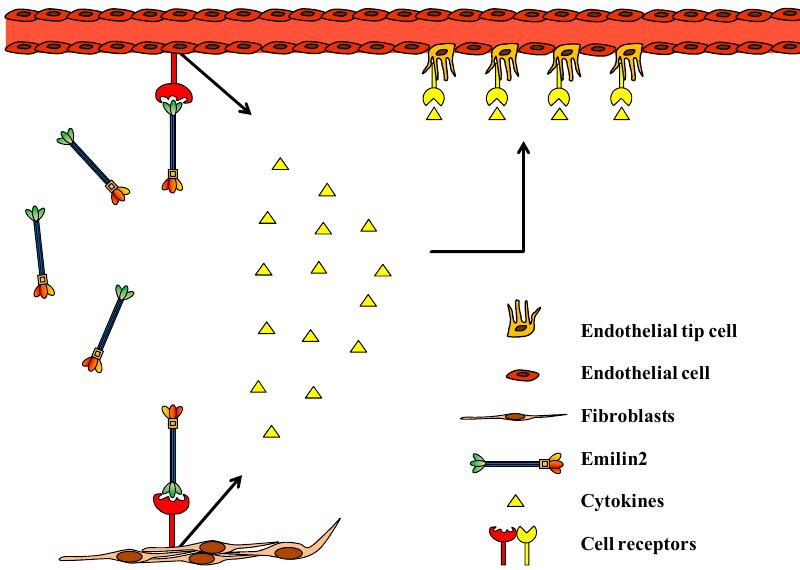
Figure 3. EMILIN2 stimulates angiogenesis via an RTK-dependent cytokine production. Schematic representation of the molecular mechanisms elicited by EMILIN2. The molecule interacts directly with membrane receptors present in both ECs and fibroblast. This leads to the activation of an intracellular signaling cascade that results in the overproduction of angiogenic cytokines that, in turn, boost EC proliferation and migration.